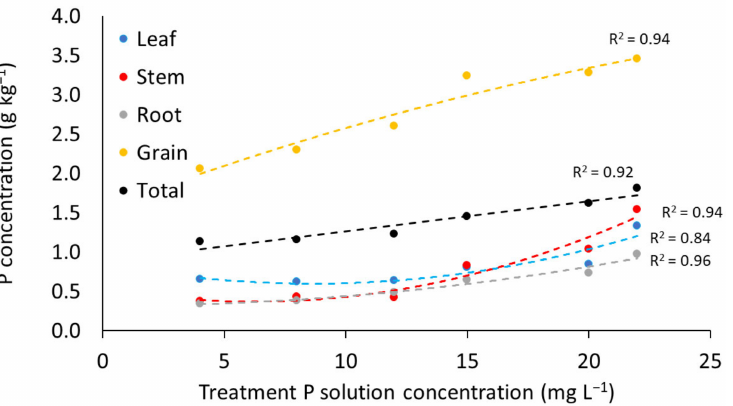
Figure 3. Plant tissue phosphorus (P) concentration for solution P concentration treatments averaged across three hybrids and four replications. “Stem” includes stem, cob, and tassel, and “Leaf” includes leaves and husk.